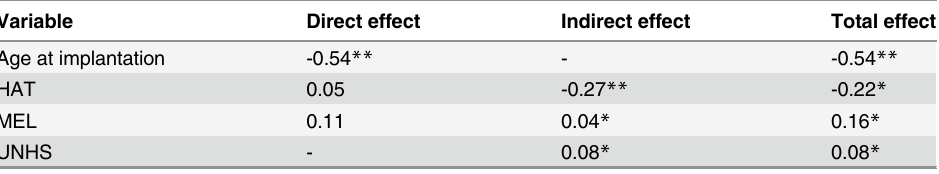
Table 4. Standardized direct, indirect, and total effects of variables on speech perception (N =